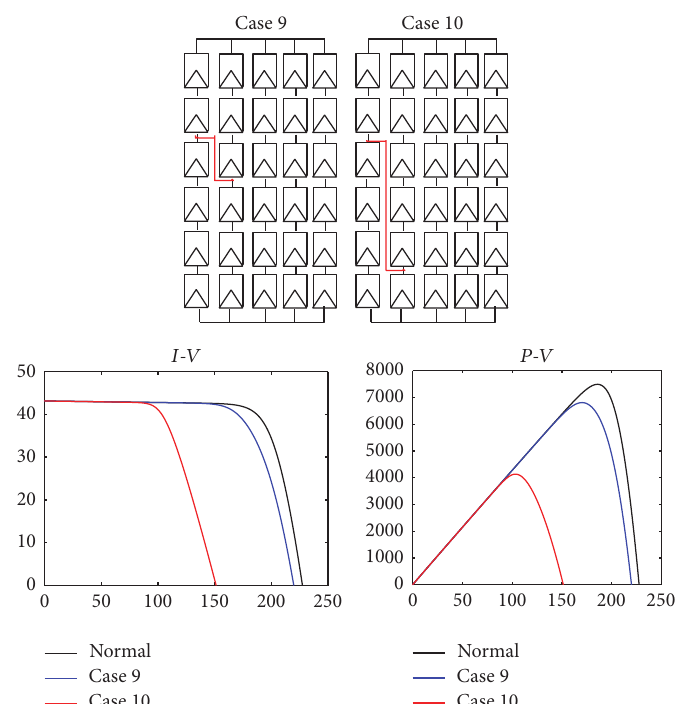
Figure 8: The PV array configuration for bridge fault.